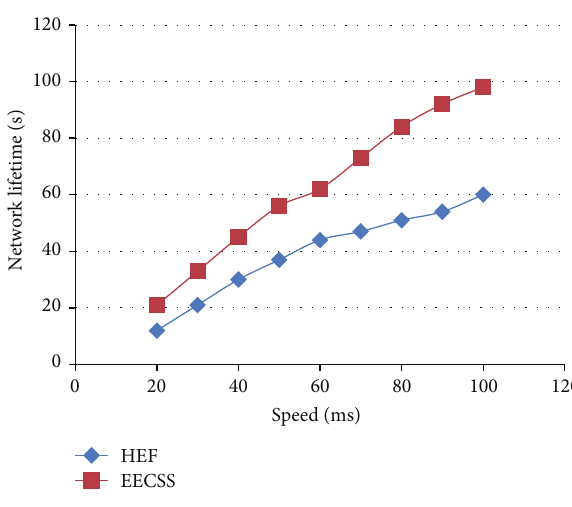
Figure 4: Speed versus network lifetime.